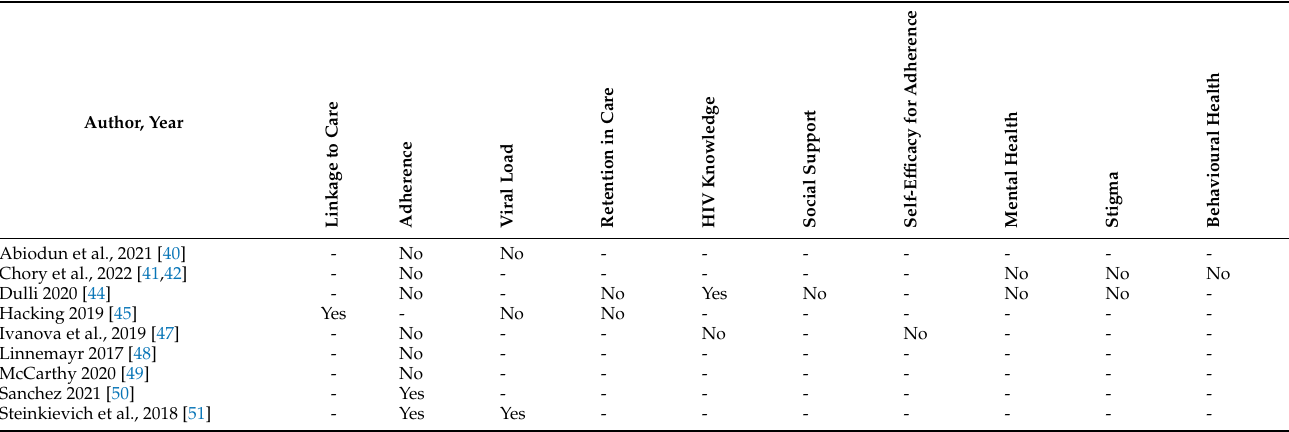
Table 5. Summary of primary